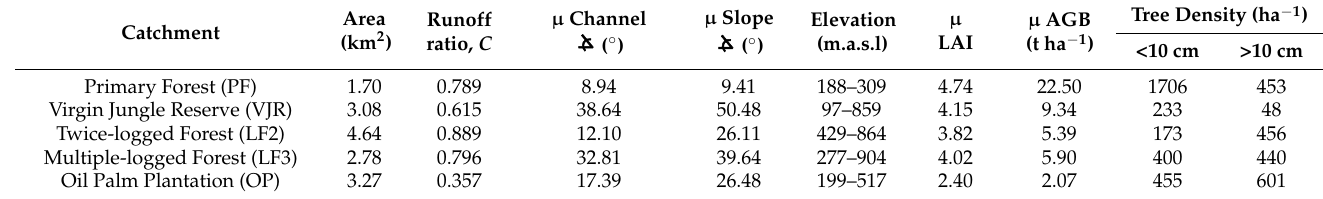
Figure 1. Study area. Reprinted/adapted with permission from Nainar et al. [1]. 2018, Elsevier. Table 1. Catchment characteristics. Source: Nainar et al. [1]. Table 1. Catchment characteristics. Source: Nainar et al. Table 1. Catchment characteristics. Source: Nainar et al. [1].